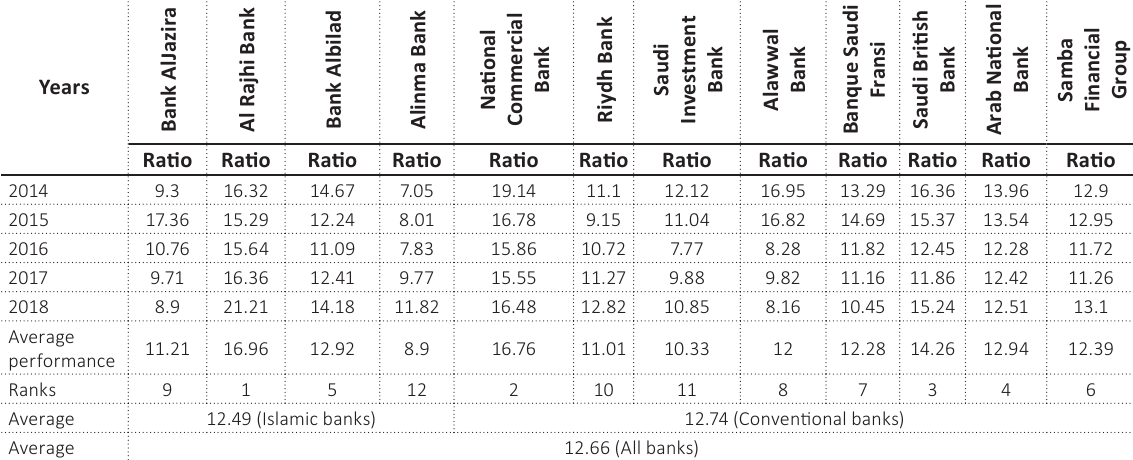
Table 2. Return on equity